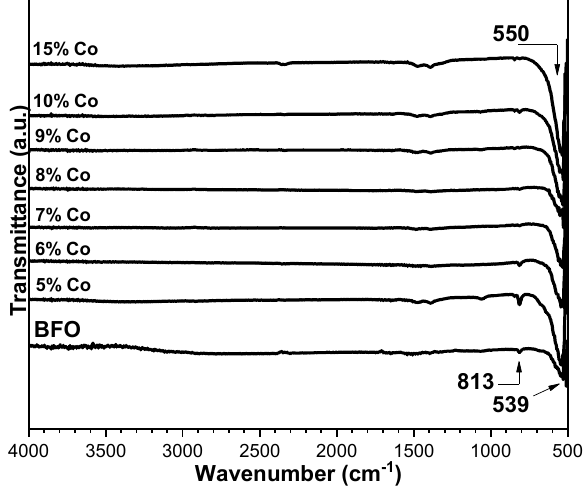
Figure 4. FTIR spectra of Co-doped BiFeO 3 powders synthesized at different levels of Co doping.